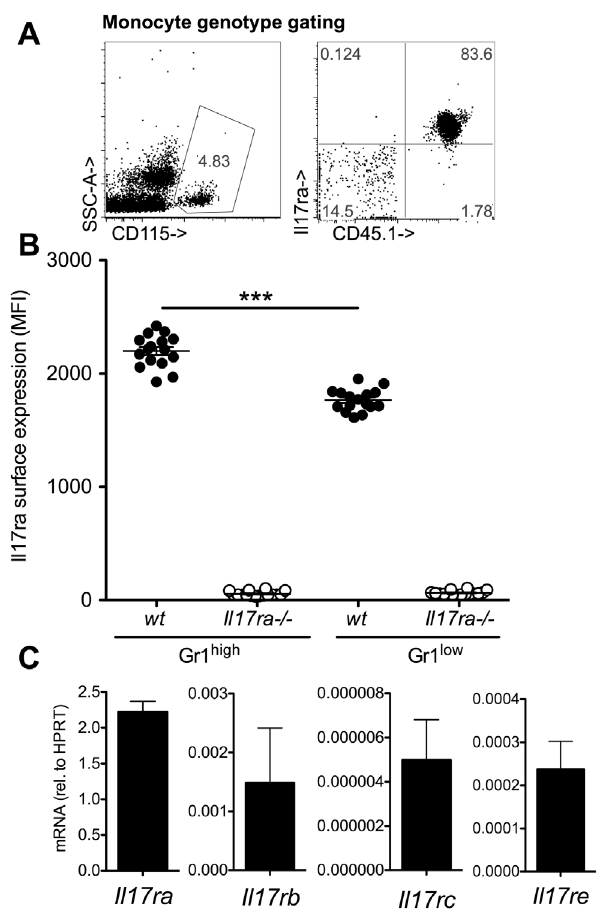
Figure 2. Monocyte characterization in mixed chimeric wt/IL-17 receptor A deficient mice. Monocyte analysis in mixed bone marrow chimeric wt(CD45.1)/ Il17ra -/- (CD45.2) mice (recipients: CD45.2 wt mice). ( A ) Monocytes were gated by CD115 and IL-17 receptor expression was assessed as control of complete chimerism. ( B ) Gr1 high and Gr1 low monocytes in mixed chimeric mice were analyzed for the intensity of Il17ra expression (MFI, n=16 from 3 independent transplantations, Bonferroni after One-way-ANOVA). ( C ) Gr1 high monocytes were sorted from bone-marrow and expression of IL-17 receptor subunits analyzed by qPCR (means of n=2 independent cell